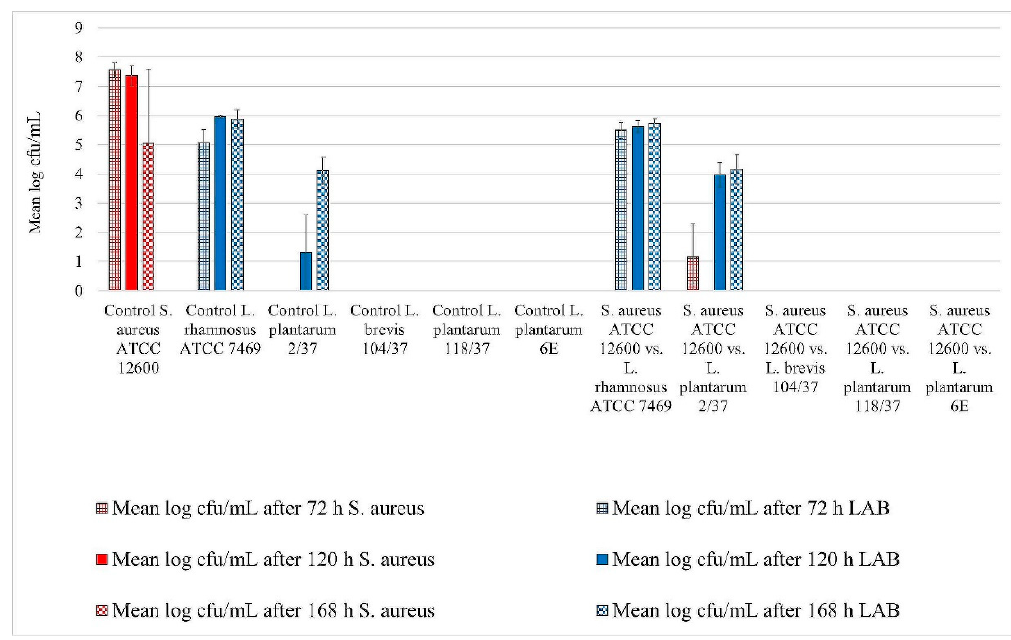
Figure 1. Biofilm challenge: Staphylococcus aureus ATCC 12,600 vs. lactic acid bacteria (LAB). Cfu/mL values are shown transformed by log (± standard error of the mean).